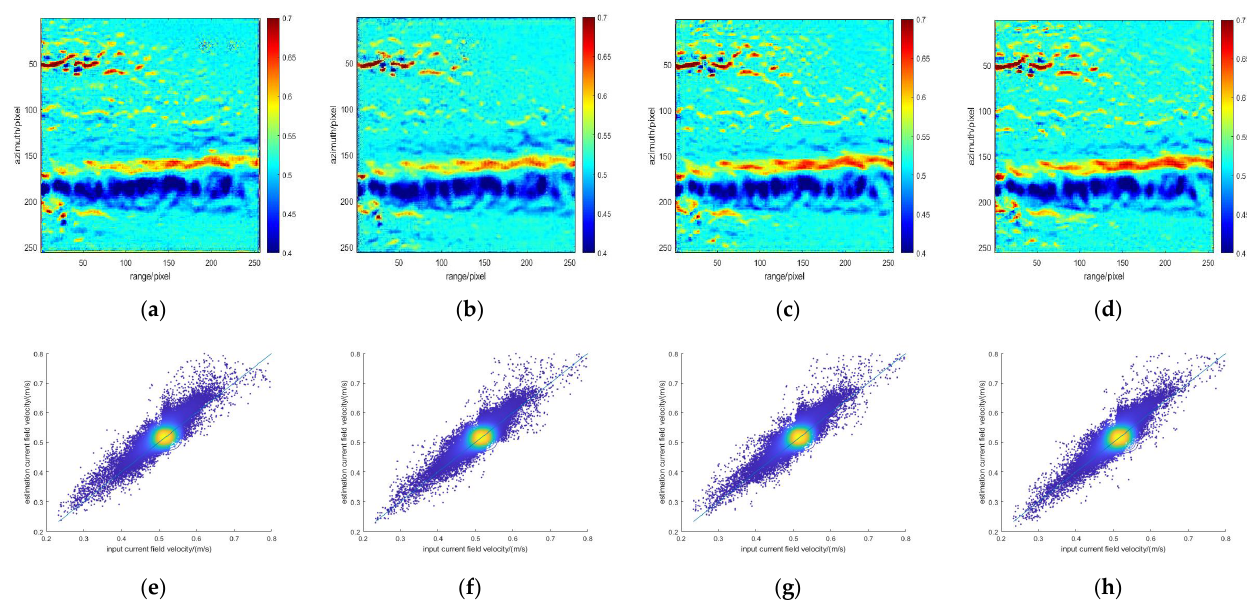
Figure 11. The estimation velocity of ocean surface currents under the different learning rates from ( a – d ): ( a ) 0.0001, ( b ) 0.0002, ( c ) 0.0003, and ( d ) 0.0004. The scatter density map between the estimation velocity of the ocean surface currents and the control group velocity of the input ocean surface currents under the different learning rates from ( e – h ): ( e ) 0.0001, ( f ) 0.0002, ( g ) 0.0003, and ( h ) 0.0004. Table 7. Statistics of the estimation results under different learning rates.